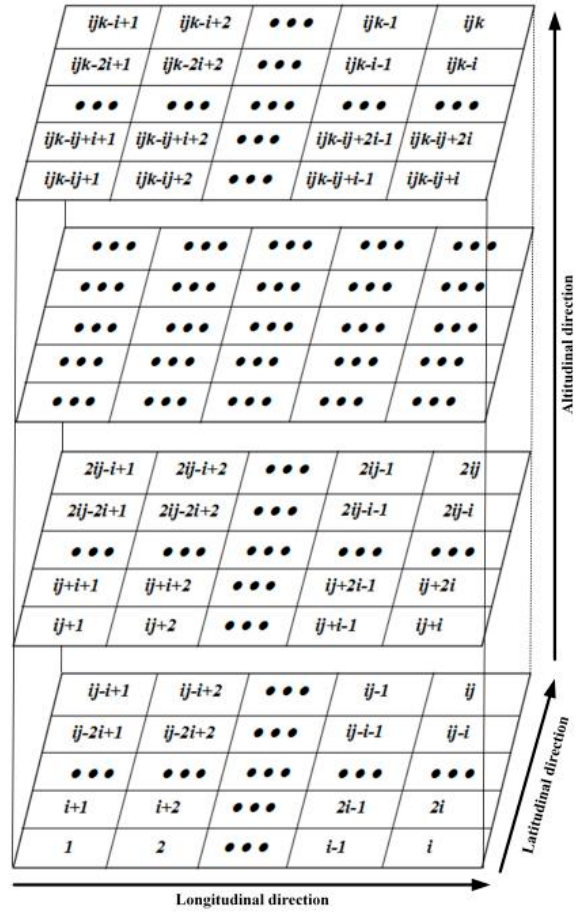
Figure 1. Sketch map of the partition and numbers of the voxel.